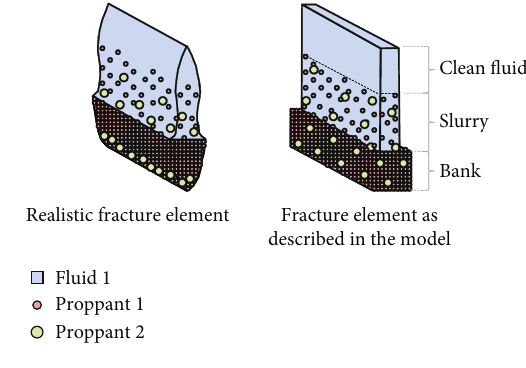
Figure 4: Schematic of fracture elements in UFM [6].